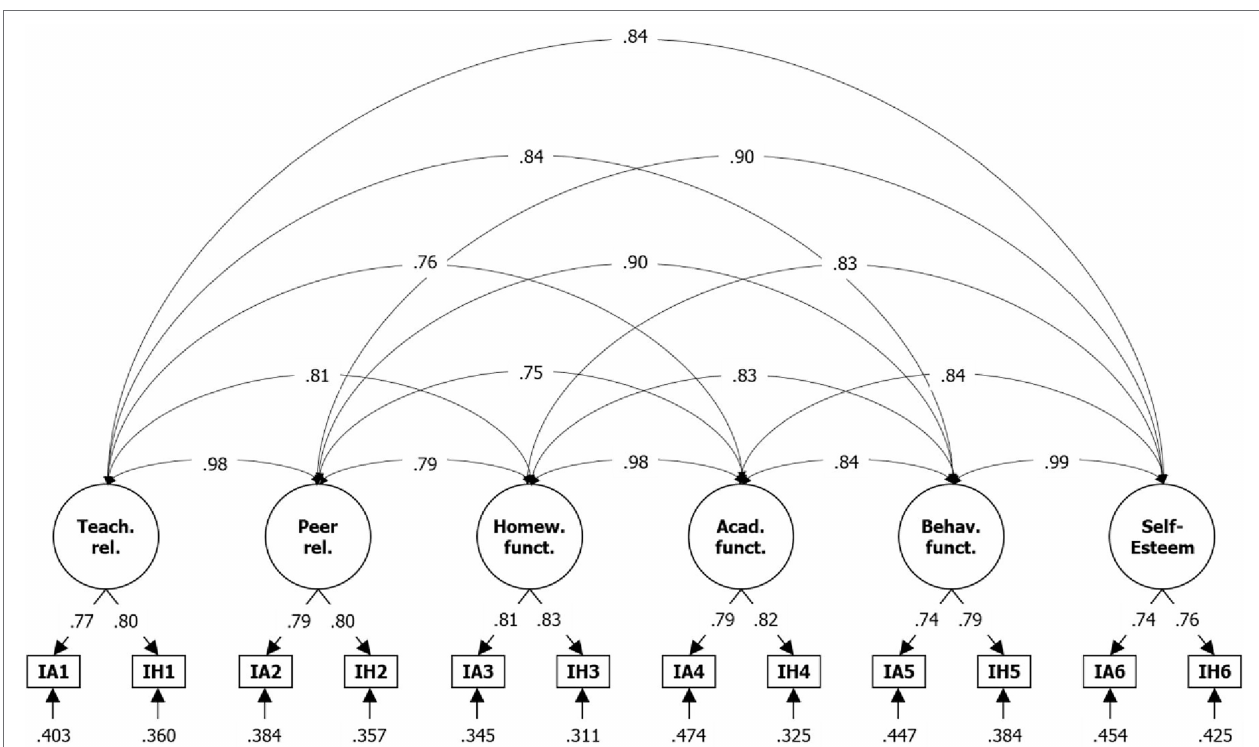
FIGURE 3 | Results from CFA for six-factor solution based on impairment items of the ADHD Rating Scale—5. IA = impairment item filled after Inatt. assessment, IH = impairment item filled after Hyp.-Imp. assessment; N = 3,742; Loglikelihood user model (H 0 ) = − 35353.921; Fits: χ 2 [39] = 1876.112, CFI = 0.932, TLI = 0.885, RMSEA = 0.112, SRMR = 0.035; bottom = residual variances, center = factor loadings (lambda), top =